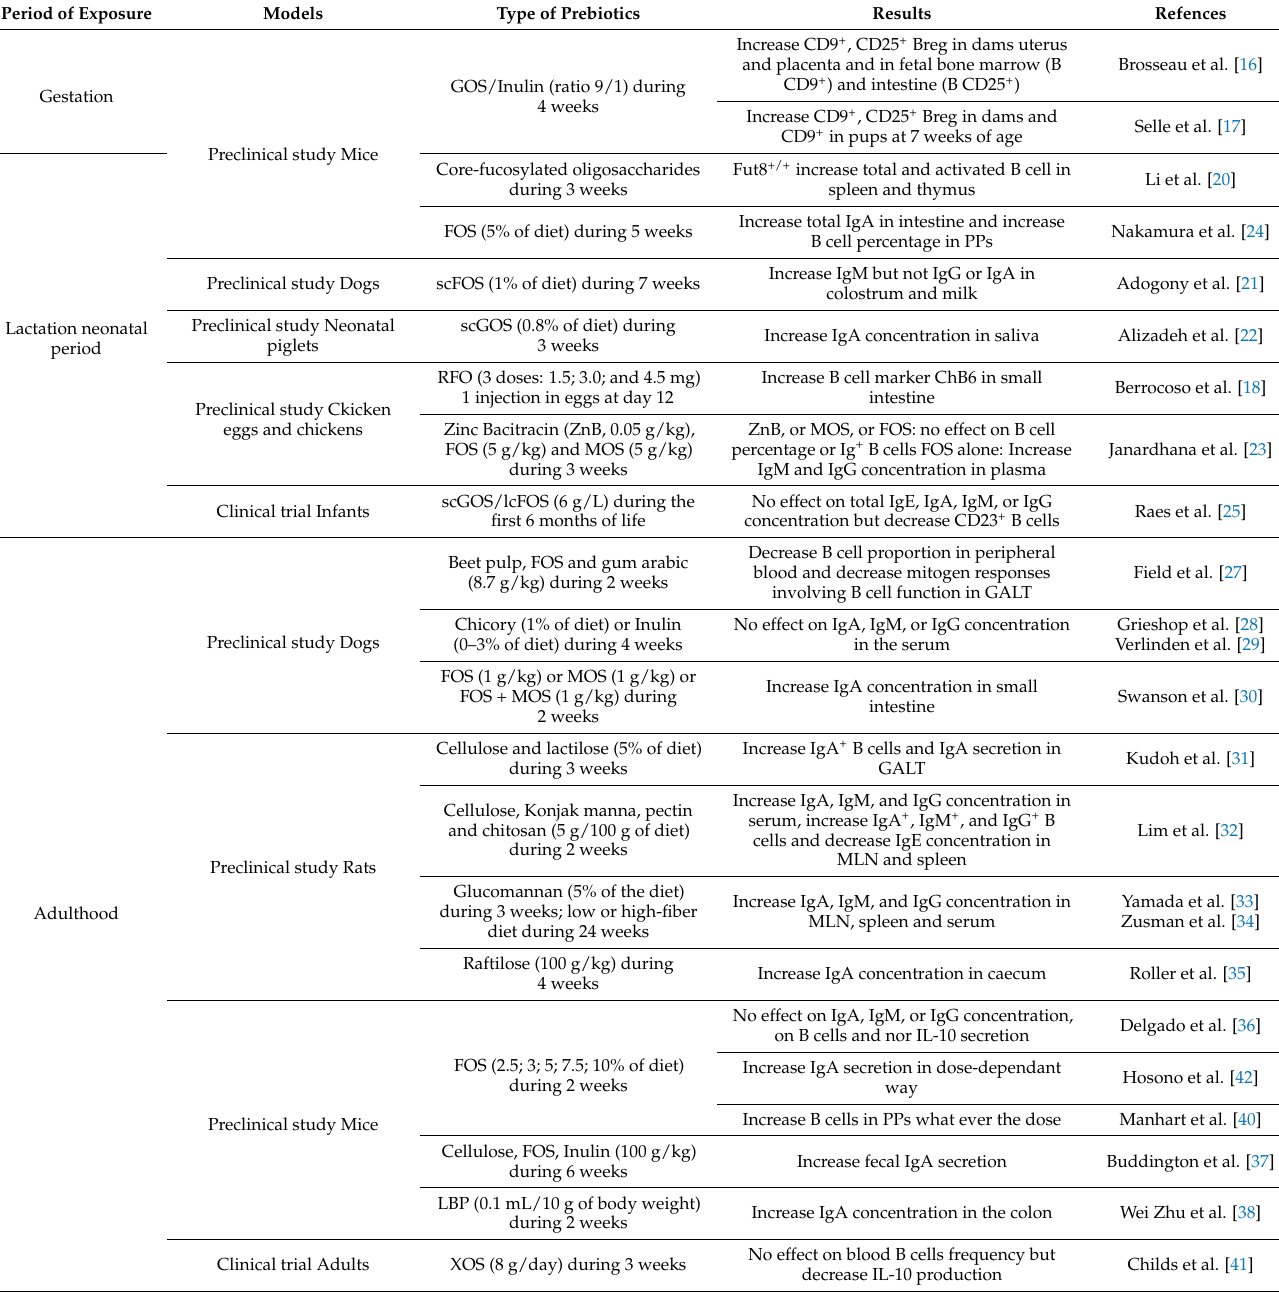
Table 1. Effects of prebiotics on immune B lymphocytes in healthy